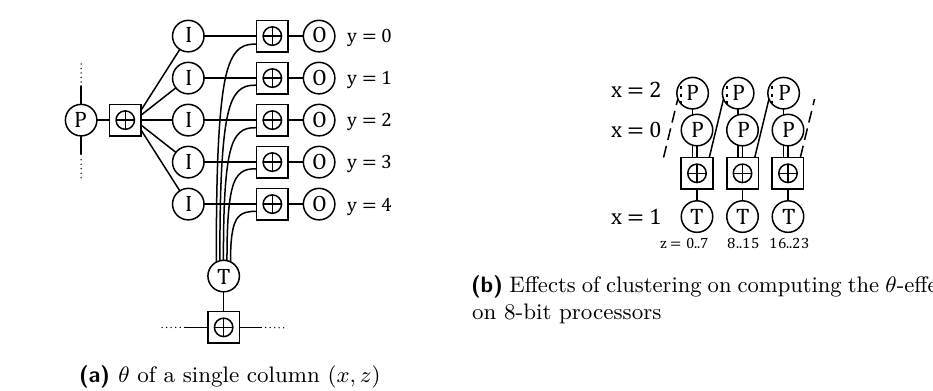
Figure 1: Factor graphs for θ . Circles denote variable nodes, factor-nodes are depicted as squares. Input and output variables are marked as I and O, respectively. Column parities are denoted as P, the θ -effect, which is computed by XORing the parity of two neighboring columns, is marked T. The ( x, y, z ) mark the positions of the bits in the state.